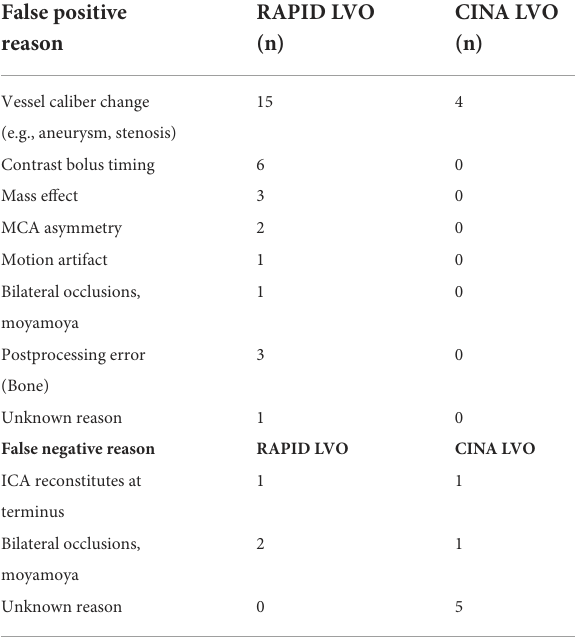
TABLE 1 RAPID LVO and CINA LVO errors as evaluated by ground